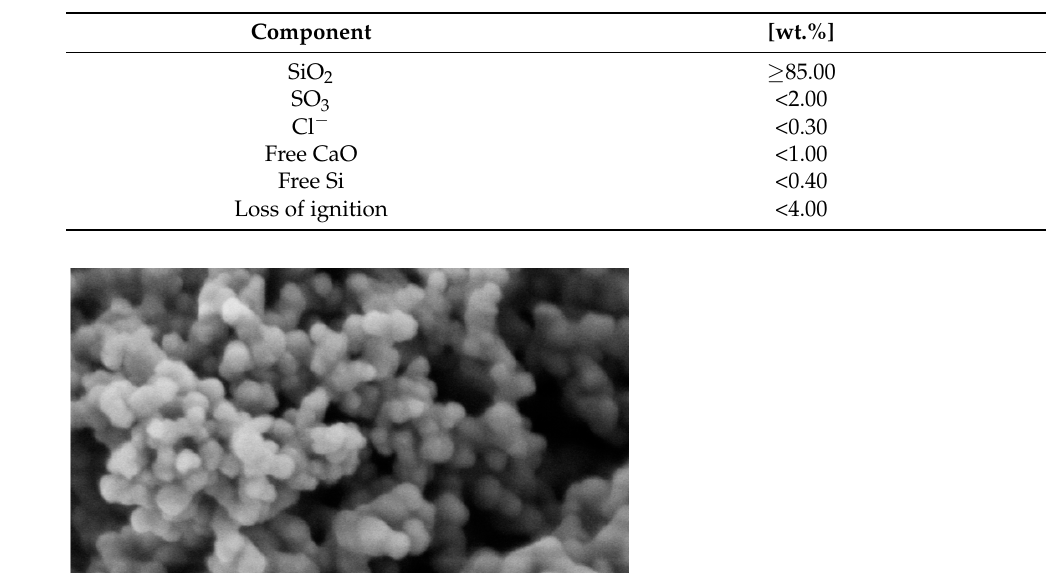
Table 2. Chemical composition of microsilica 920 EN D.